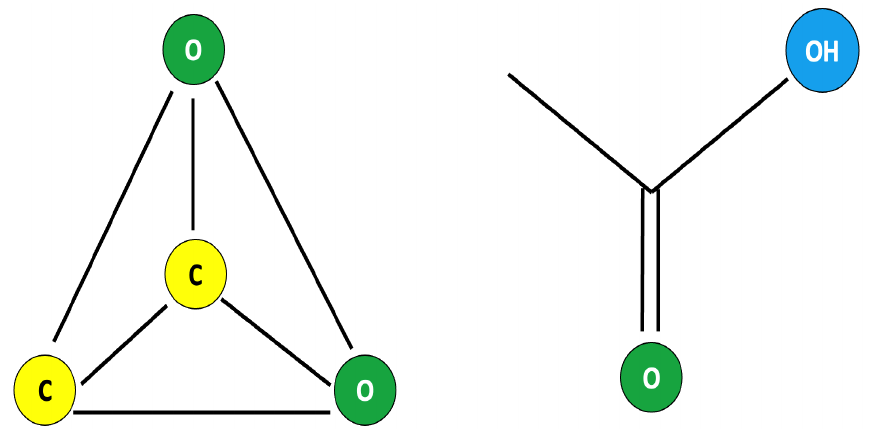
Figure 2. A chemical and structural representation of acetic acid.